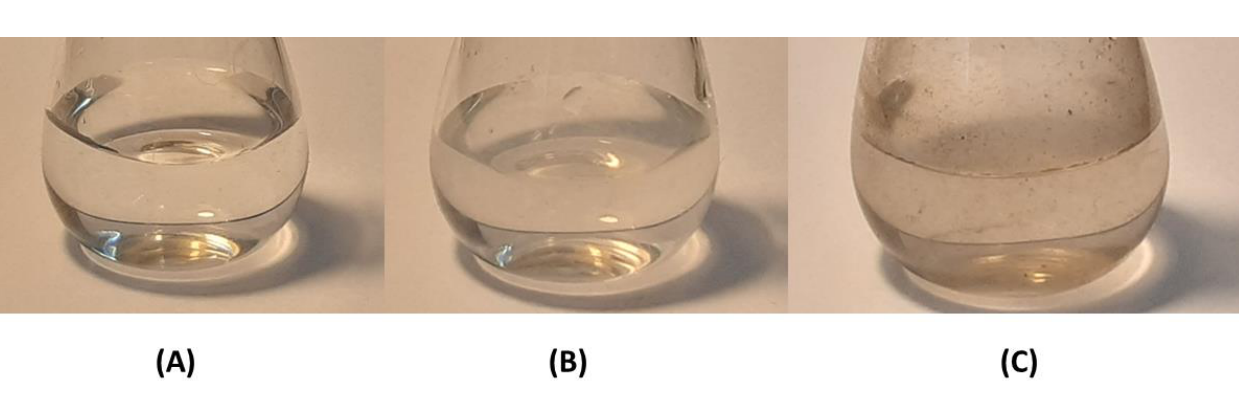
Figure 2. Change in the pH value of the drops during the storage period.